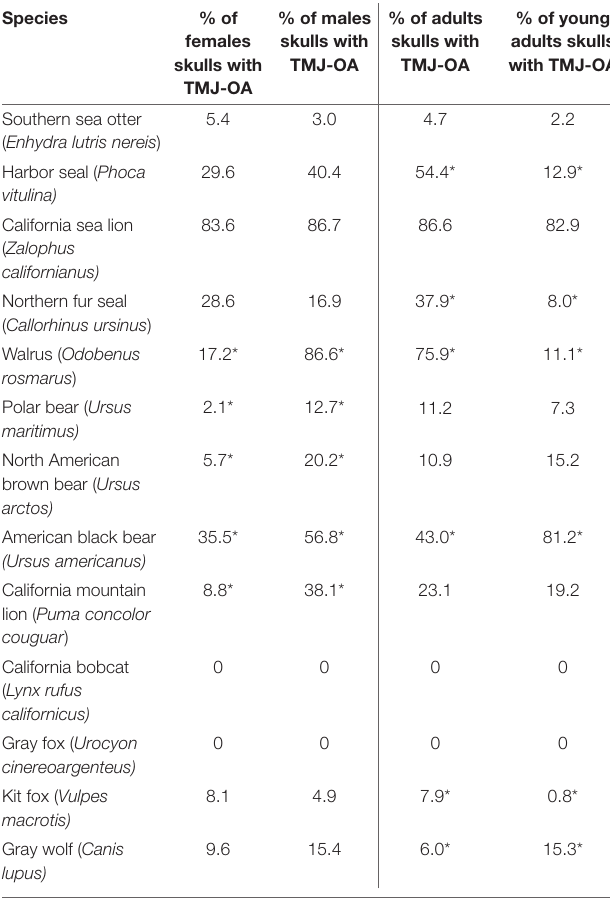
TABLE 2 | Percentages of skulls with TMJ-OA divided by sex and age